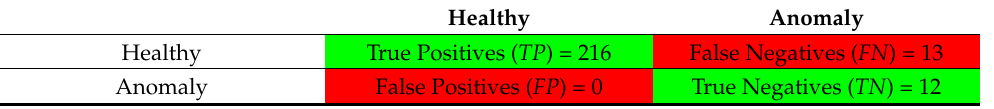
Table 4. The confusion